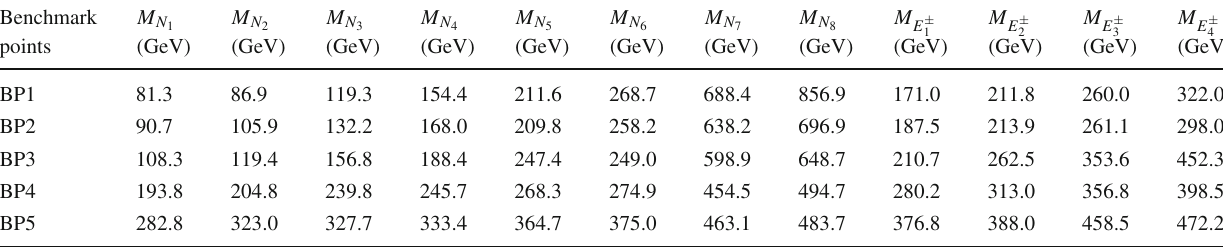
Table 4 Masses of neutral and charged VLLs for five benchmarks